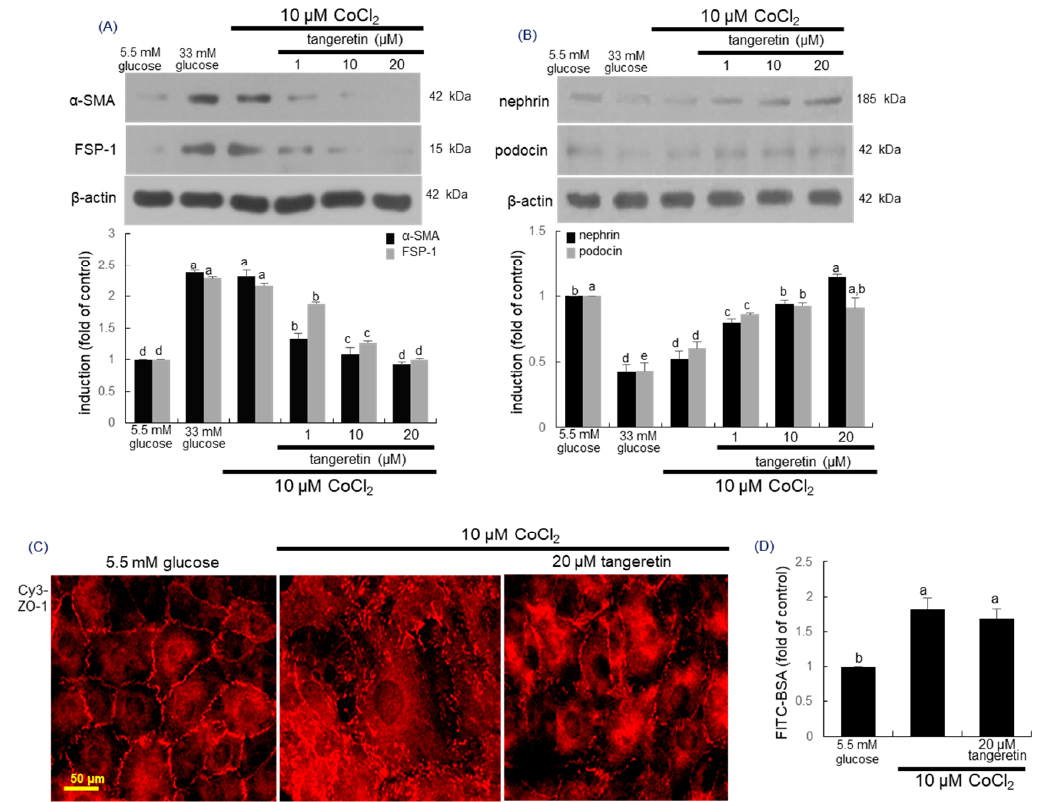
Figure 8. Effects of tangeretin on expression of α -SMA, FSP-1, nephrin, podocin and ZO-1 in CoCl 2 - exposed podocytes ( A , B , D ). Podocytes were incubated with 10 μ M CoCl 2 in the presence of 1–20 μ M tangeretin for 4 days. Podocyte lysates were electrophoresed on 8–10% SDS-PAGE and subject to Western blot analysis with a primary antibody of α -SMA, FSP-1, nephrin and podocin. β -Actin antibody was used as an internal control. The bar graphs (mean ± SEM, n = 3) represent quantitative results of each blot bands obtained from a densitometer. The ZO-1 localization was visualized with a Cy3-conjugated secondary antibody ( C ). Each photograph is representative of stained cells. Scale bar = 50 μ m. For the measurement of podocyte injury, the albumin permeability assay was performed with FITC-labeled bovine serum albumin (BSA), ( D ). Means in bar graphs without a common letter differ, p < 0.05.